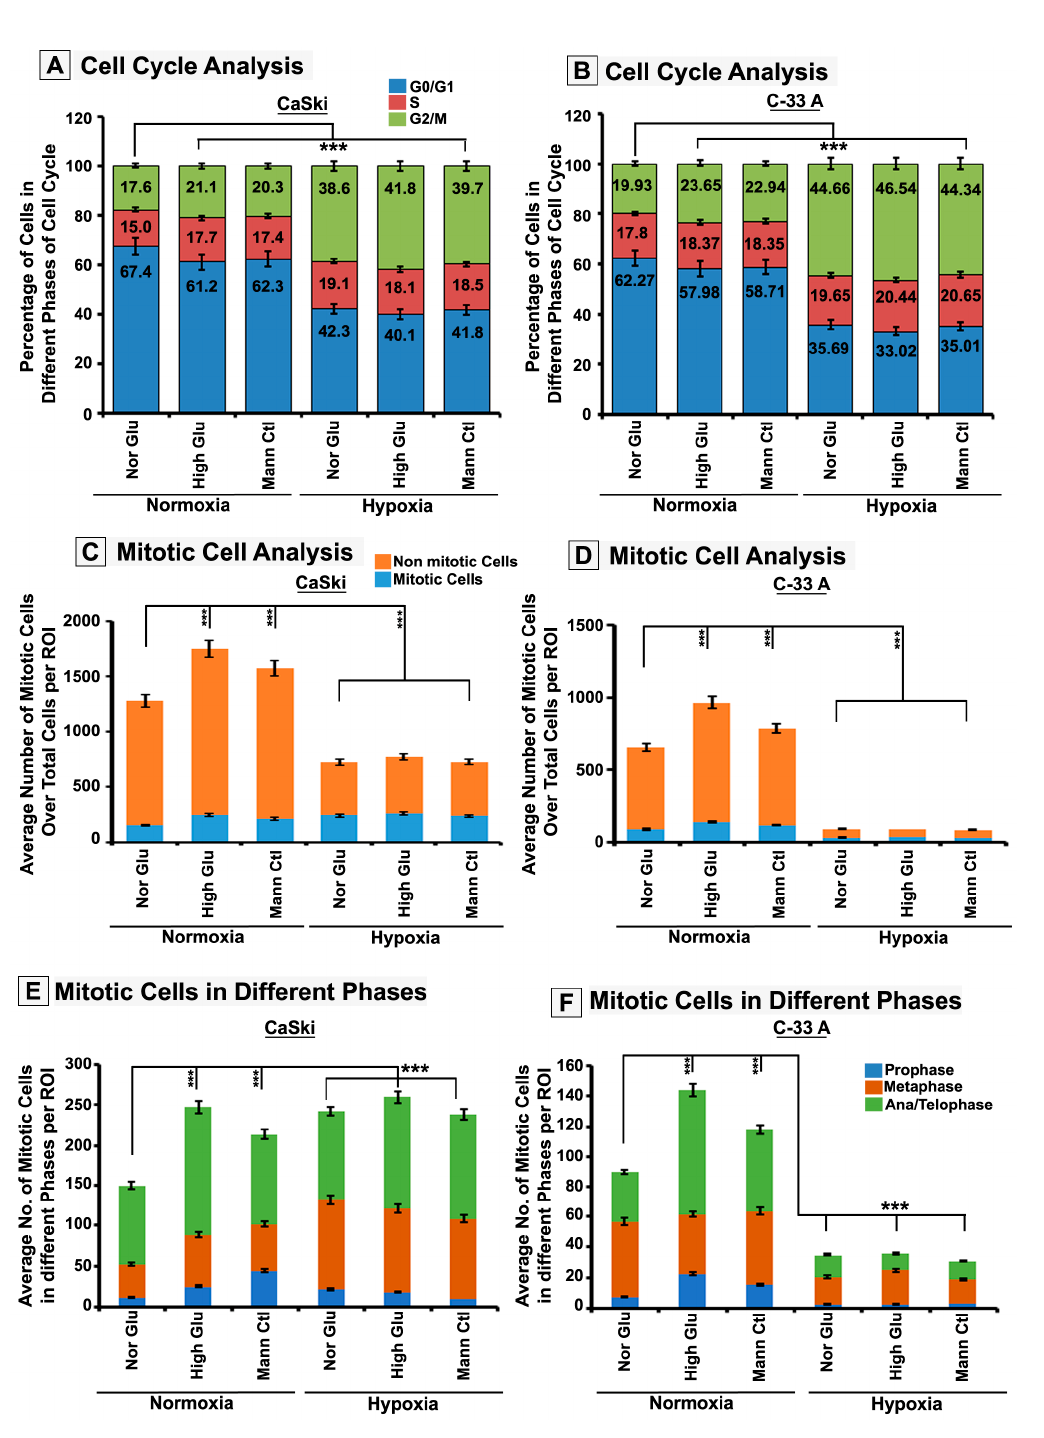
Figure 3. Acute hypoxia attenuates high-glucose hyper-osmotic stress pro-proliferative mechanoadaptive effects by promoting mitotic M-phase arrest. CaSki/C-33A cervical cancer cells were cultured for 96 h in NG, HG and HG-HO with or without hypoxia stimulation. ( A , B ) FACS- assisted cell cycle analysis was performed. ( C , D ) Average mitotic cell counts over the total cell number per ROI were obtained to estimate whether more cells were stalled in mitosis over total cells in each condition. ( E , F ) The images of mitotic cells per ROI were further scored into different mitotic (pro, meta and ana/telo) phases manually to estimate whether the distribution of mitotic cells in these phases could correlate with total cell numbers or not. Statistical significance is represented by p values: *** p ≤ 0.001